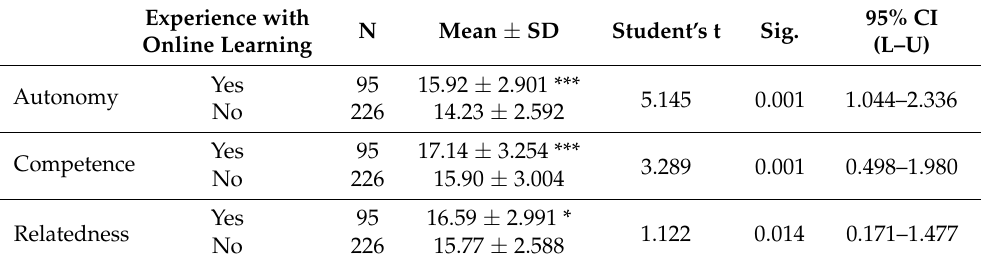
Table 4. Effect of previous experience in online learning on autonomy, competence, and relatedness.